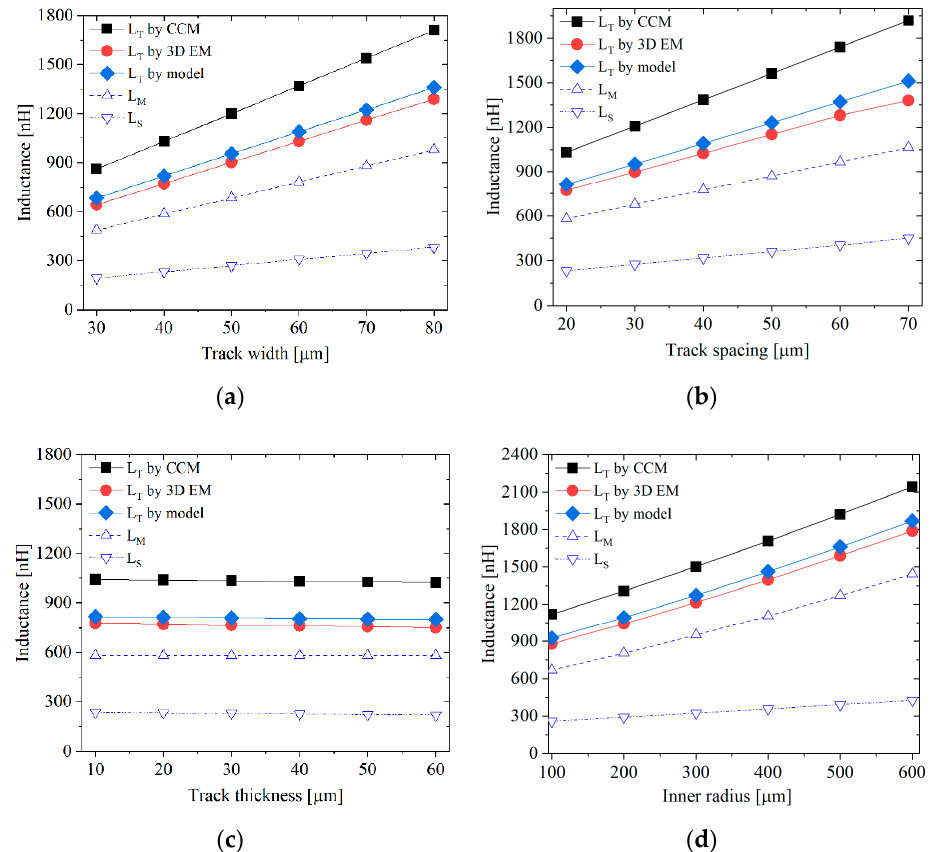
Figure 4. Impact of ( a ) track width, ( b ) track spacing, ( c ) track thickness and ( d ) inner radius on the total inductance.